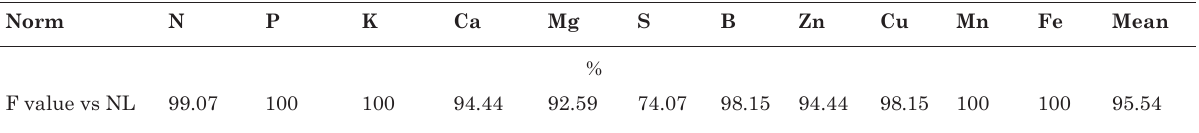
table 6. frequency of plots with consistent diagnoses of the nutritional status, determined by the f value and natural log transformation (nl) norm